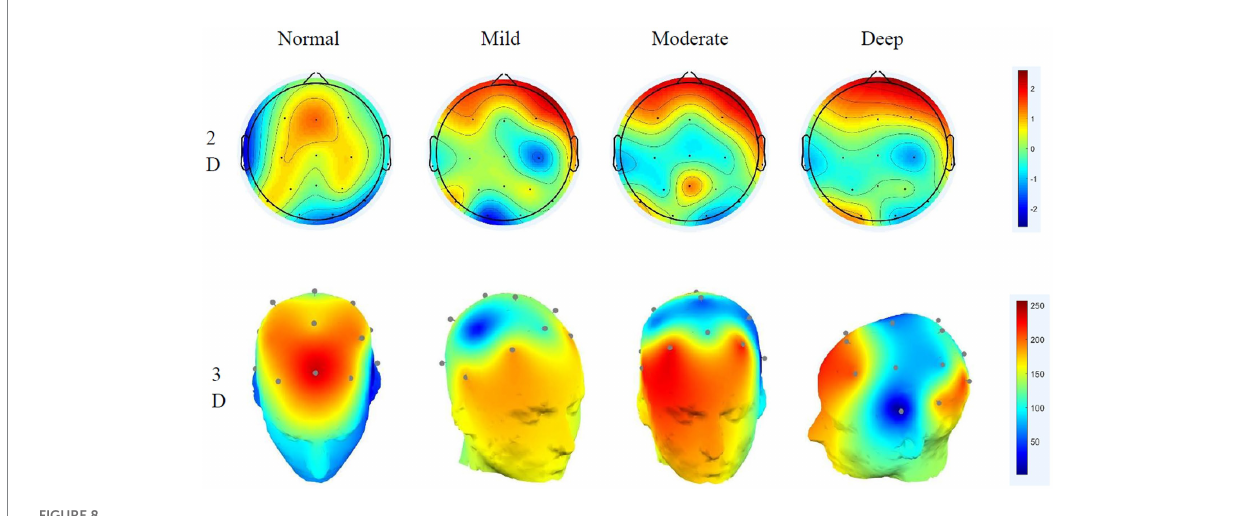
FIGURE 8 Beta wave 2D–3D EEG topography in different states.